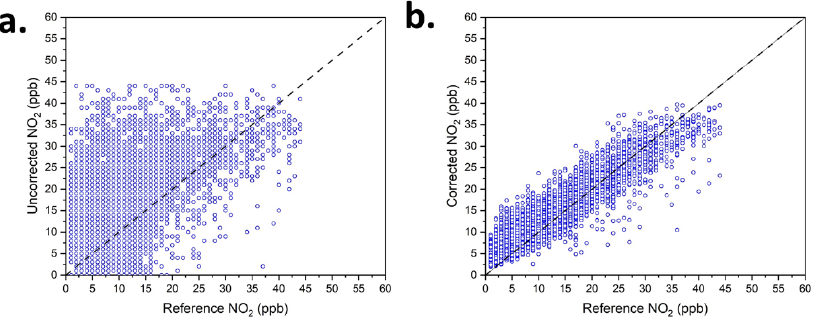
Figure 3. ( a ) Uncorrected hourly NO 2 sensor readings versus the observed reference NO 2 concentra- tion, ( b ) RF-corrected NO 2 sensor readings versus the observed reference NO 2 concentration. Both diagrams refer to the test set (2022).